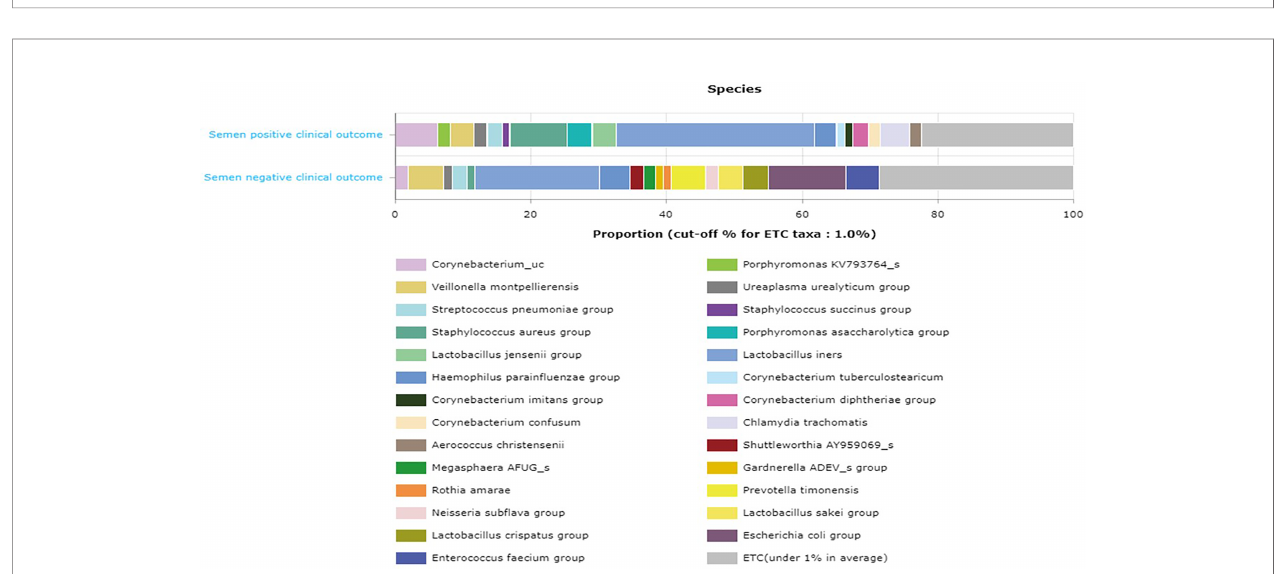
FIGURE 6 | Comparative relative abundance of some selected taxa showing signi fi cant difference between semen samples with positive IVF clinical outcome and samples with negative IVF clinical outcome.